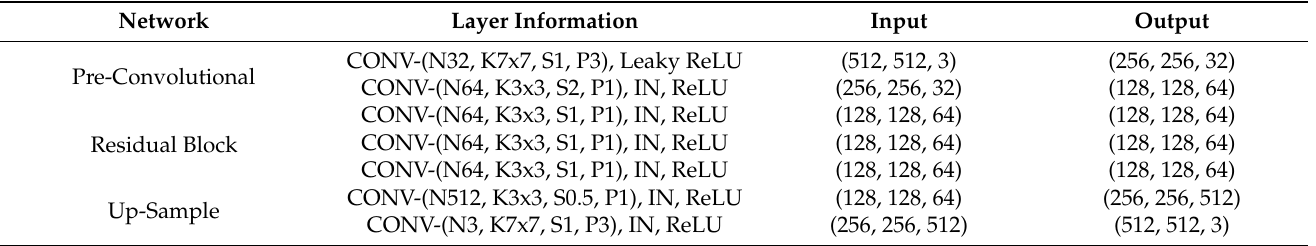
Table 1. The system architecture of the local generator.